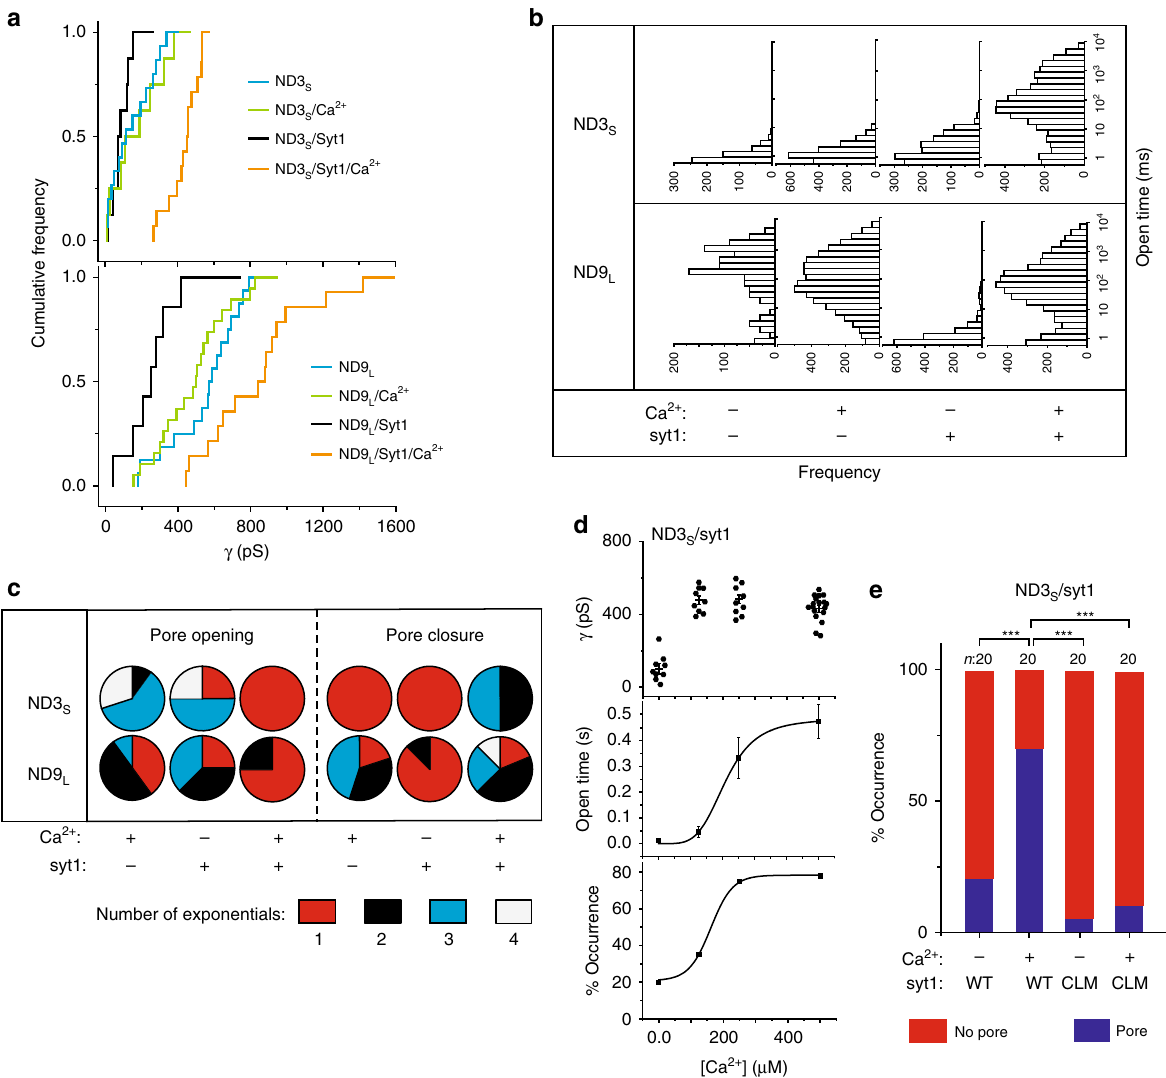
Fig. 2 Quanti fi cation of syt1-regulated fusion pore properties. a Cumulative distribution functions (CDF) of single-channel conductances across different trials for each experimental condition. b Open dwell time histograms for ND3 S and ND9 L , plus or minus syt1 and Ca 2 + , are shown. c Pie diagrams showing the number of exponentials required to fi t the open- and closed-state CDFs for individual pores under the indicated conditions. Details are described in Supplementary Fig. 4. d Conductance values ( γ ) (upper panel), open time (middle panel), and percentage of occurrence (lower panel) at each indicated [Ca 2 + ] free are plotted. n = 16, 10, 10, 15; three different sets of ND preparations were used. In the open time plot, mean values for the open-state dwell times of individual traces were quanti fi ed. Error bars indicate SEM. e Percentage of occurrence of pore formation, plotted for WT syt1 versus a Ca 2 + ligand mutant (CLM), D230/232N/D363/365N, that fails to bind Ca 2 + via either C2 domain. The number of independent trials ( n ) are indicated in e . Pearson ’ s χ 2 analysis was performed; *** p <